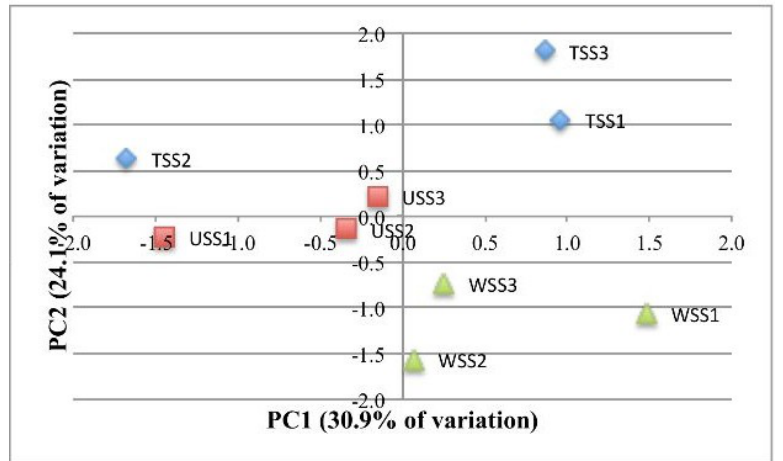
Figure 5. ( a ) A two-dimensional plot of principal component factor scores of rotated relative abundance values. ( b ) A two-dimensional ordination of weighted Unifrac